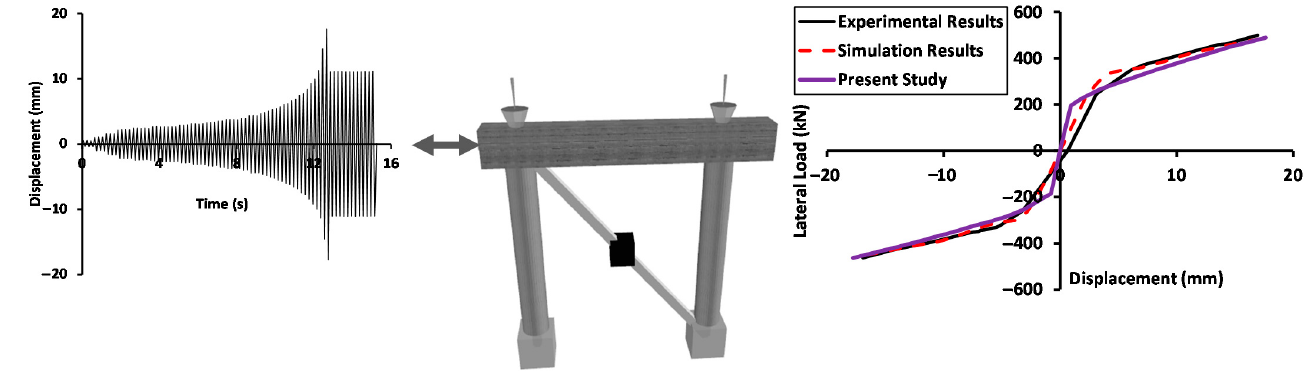
Figure 6. Comparison of inelastic analysis results and previous experimental and analytical studies of as-built bridge bent: cyclic loading protocol used in the multi-column bridge bent inelastic anal- ysis ( left ) and backbone curves ( right ).